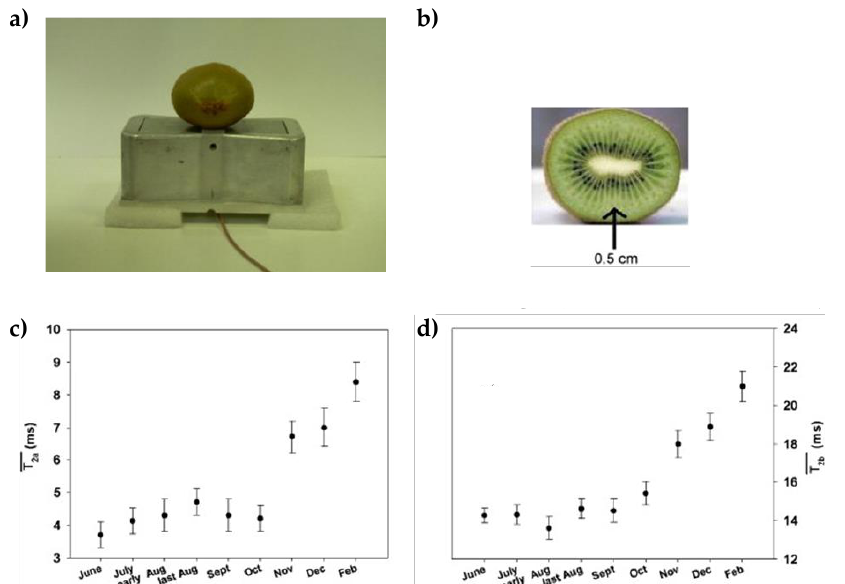
Figure 3. ( a ) Measurement of intact kiwifruit with a portable unilateral NMR instrument. ( b ) Section of kiwifruit showing the depth of measurement with a portable NMR instrument. Average T 2a ( c ) and T 2b ( d ) were measured on nine kiwifruits vs. the harvesting month; the error bars represent the maximum error calculated with the error propagation theory (Adapted from [17] with permission from Elsevier, Copyright 2010).